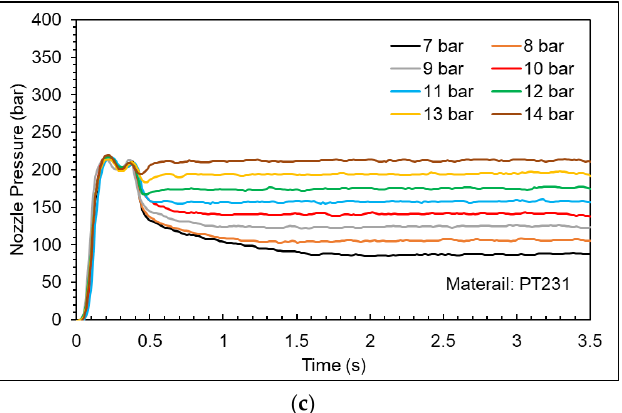
Figure 16. Nozzle pressure profile at different packing pressures (( a ) 6331 − 8, ( b ) 6331, and ( c ) PT231).